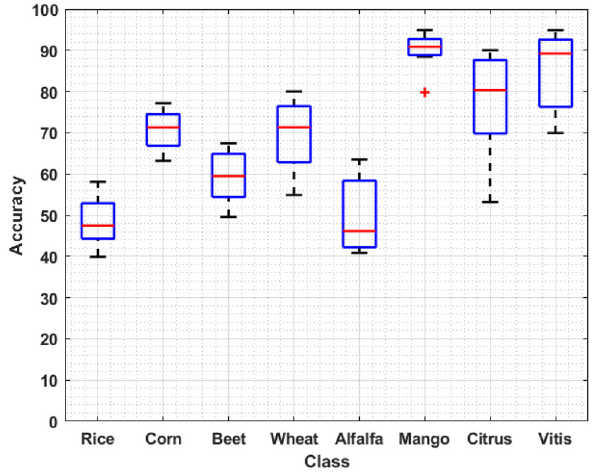
Fig. 6 Accuracy of the proposed method over crop-wise pest classes